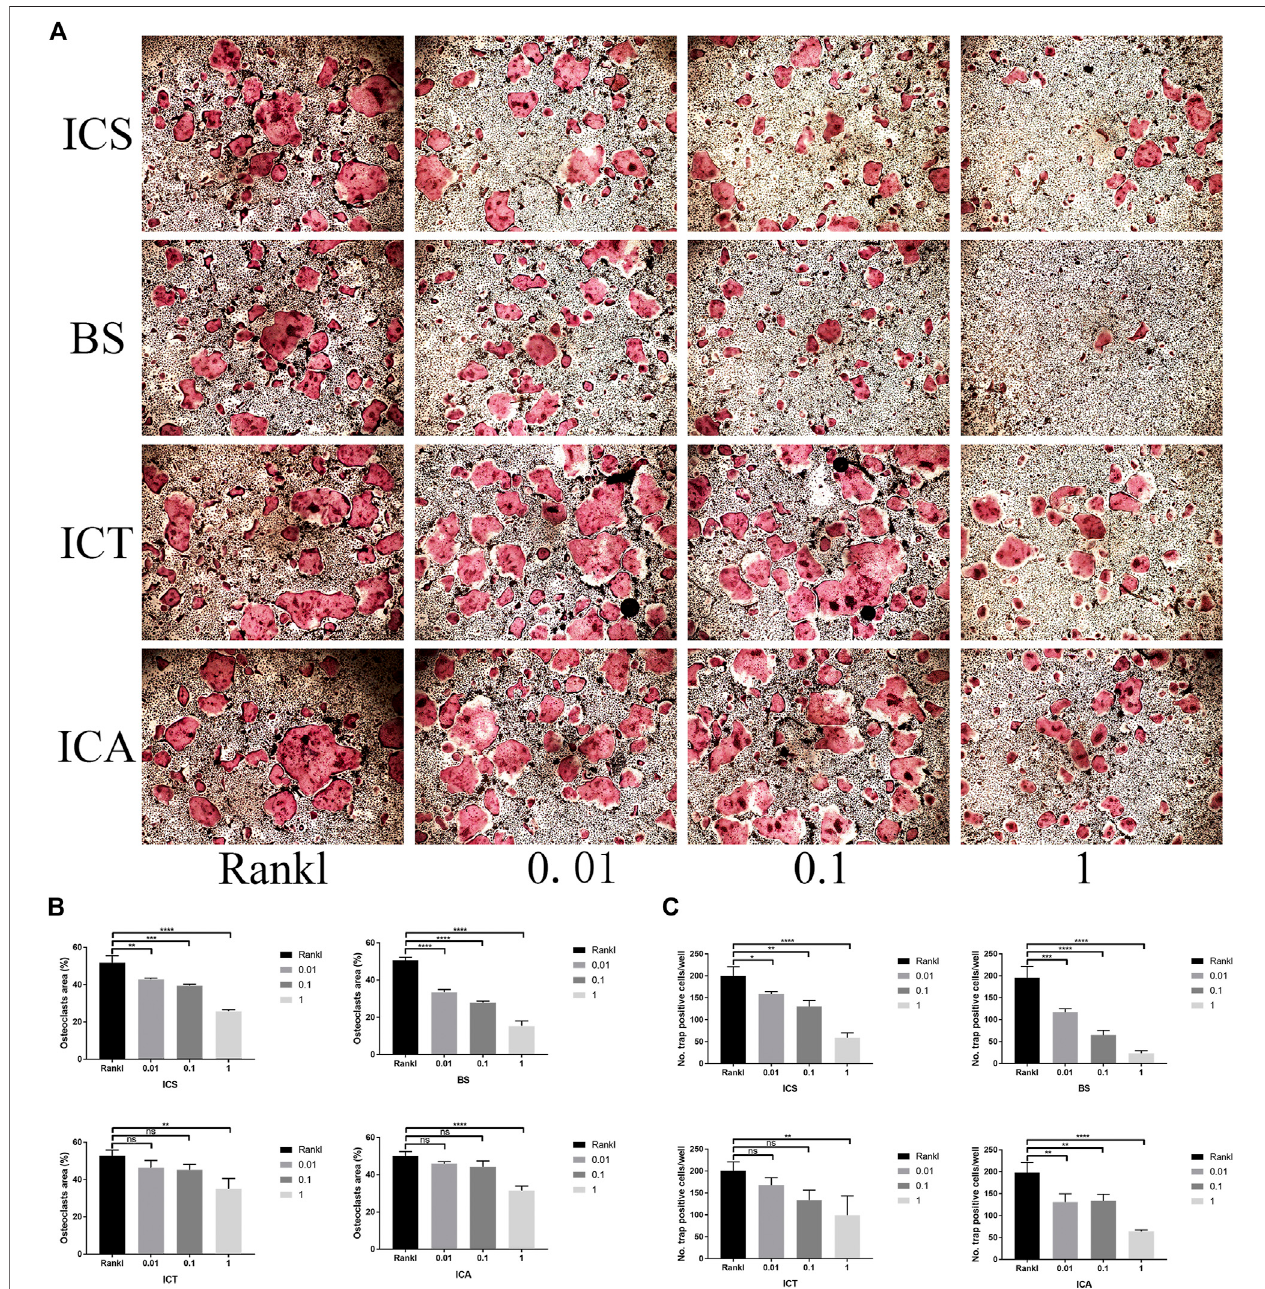
FIGURE 3 | ICA and its metabolites (ICS, BS, and ICT) suppressed RANKL-induced osteoclastogenesis, and BS showed the most excellent effect. (A) TRAP Staining shows the different concentrations of ICS, BS, ICT, and ICA inhibiting osteoclast formation (B,C) TRAP-positive cells and area were quanti fi ed after the administration of different concentrations of ICS, BS, ICT, and ICA and indicated that BS showed optimal effect on suppressing osteoclast differentiation at different concentrations. All bar graphs are presented as mean ± SD; n = 3. p p < 0.05; pp p < 0.01; **** p < 0.0001; ns, not statistically signi fi cant.